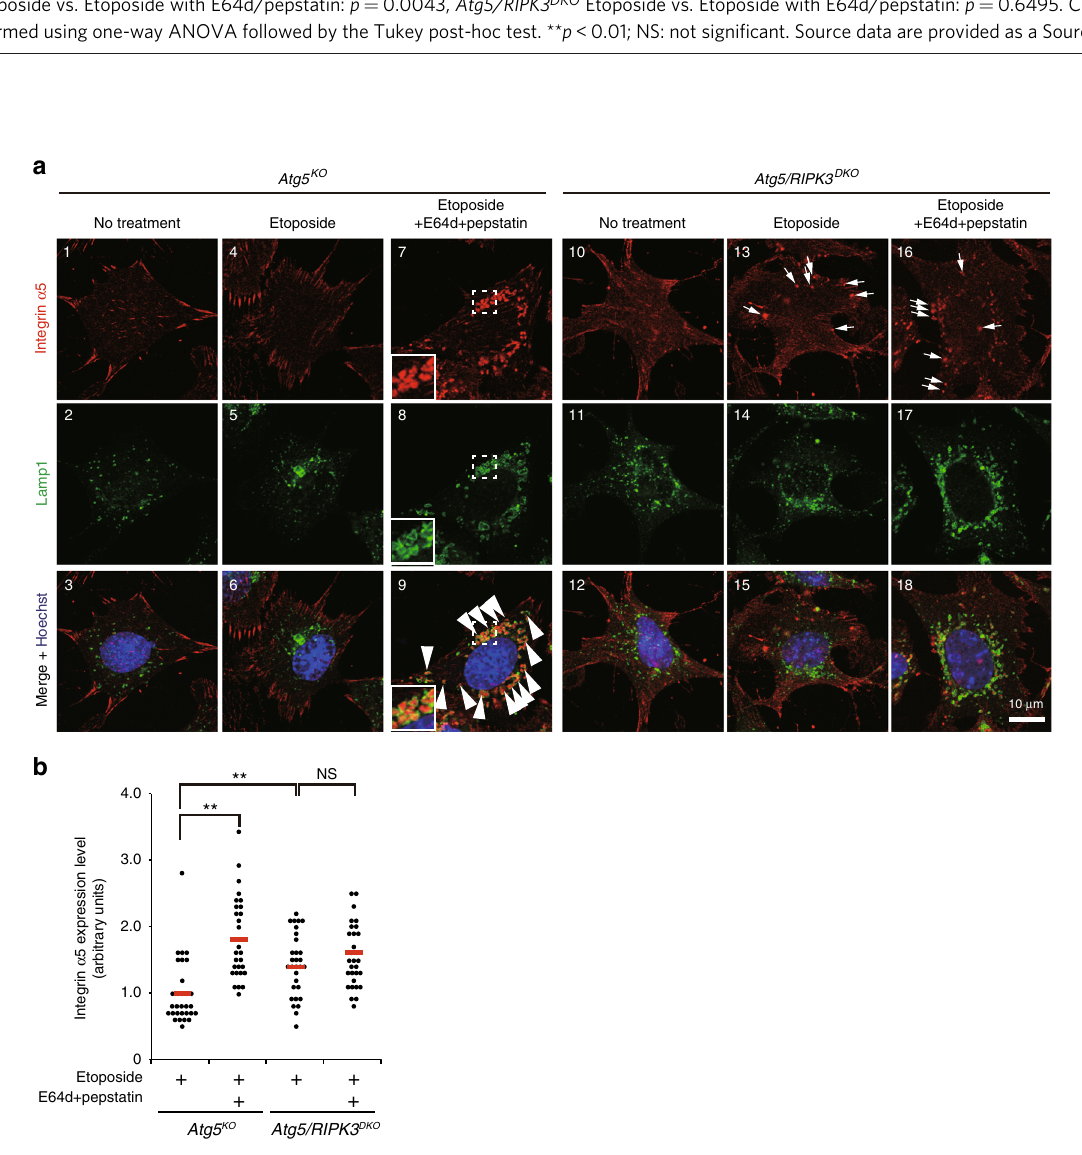
Fig. 10 Requirement of RIPK3 for undelivered integrin α 5 degradation upon etoposide treatment. The Atg5 KO MEFs and Atg5/RIPK3 DKO MEFs were treated with or without etoposide (10 µ M) in the presence of E64d/pepstatin for 12 h. Cells were immunostained with anti-Lamp1 and anti-integrin α 5 antibodies. In a , representative images are shown. Arrows and arrowheads indicate unusual cytoplasmic integrin alpha5 puncta and integrin α 5 engulfed in autolysosomes, respectively. Magni fi ed images of the areas within the dashed squares are shown in the insets. Note that etoposide generated unusual cytoplasmic integrin alpha5 puncta in Atg5/RIPK3 DKO MEFs. In b , the amount of total integrin α 5 (the level of fl uorescence intensity per cell) was measured ( n = 30 cells in each experiment). Red bars indicate mean values. Atg5 KO vs. Atg5/RIPK3 DKO Etoposide: p = 0.0093, Atg5/RIPK3 DKO Etoposide vs. Etoposide with E64d/pepstatin: p = 0.744. Comparisons were performed using one-way ANOVA followed by the Tukey post-hoc test. ** p < 0.01; NS: not signi fi cant. Source data are provided as a Source Data fi